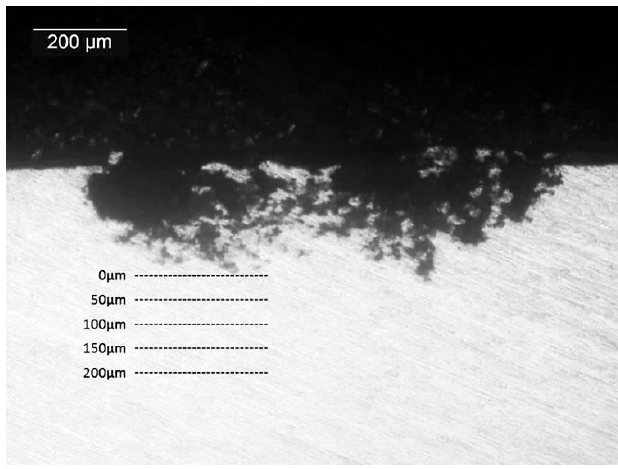
Figure 2. Placement of the nanoindentation hardness measurements from the bottom of the pit.